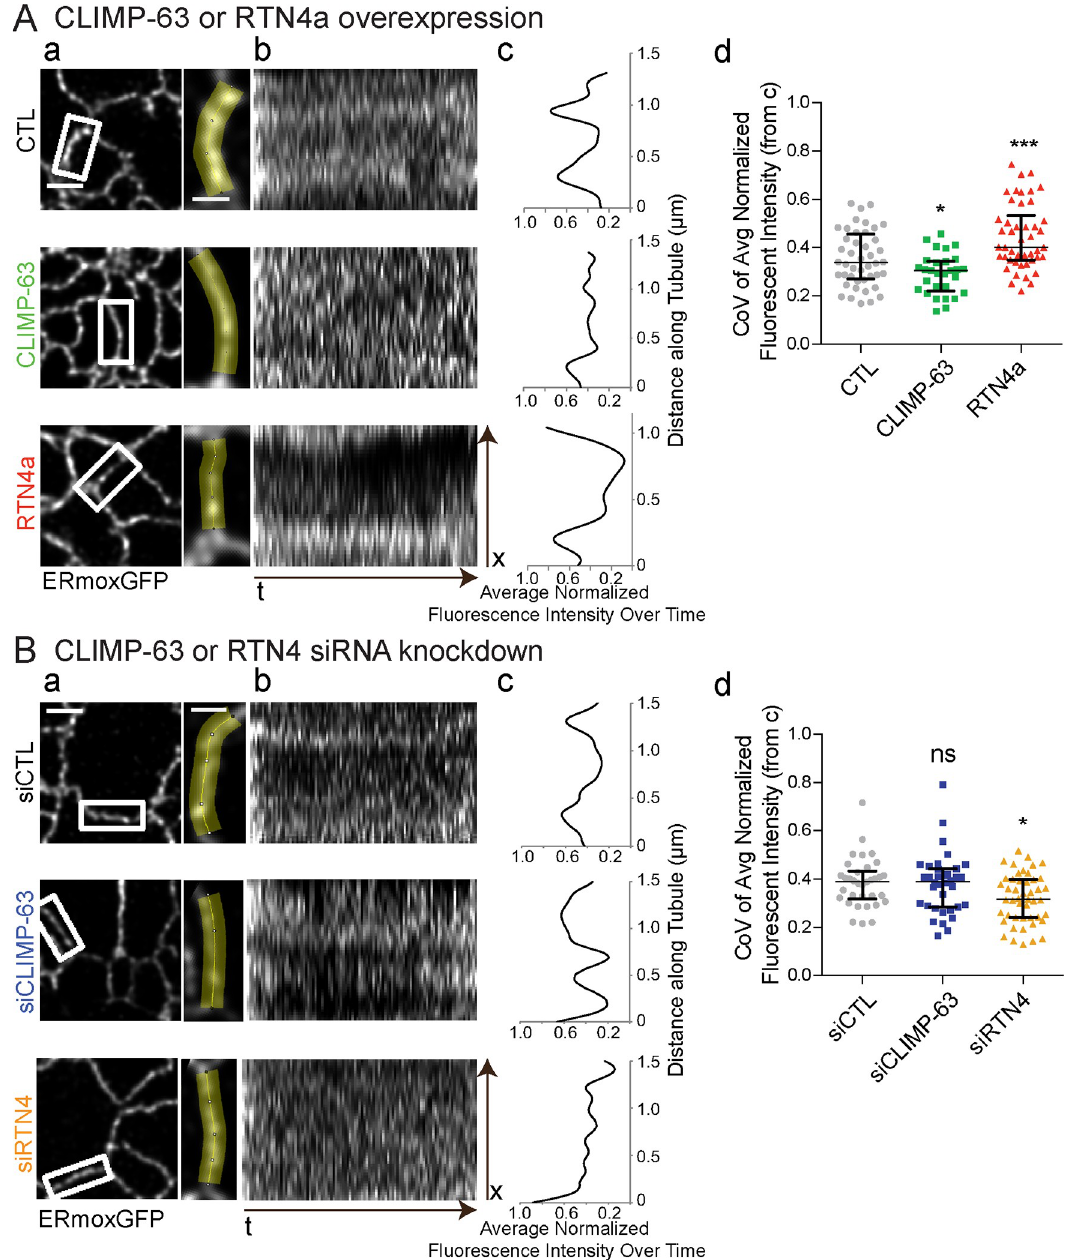
Fig 6. RTN4a and CLIMP-63 regulate dynamics of lumenal nanodomain compartmentalization along peripheral ER tubules. STED live cell imaging (40 ms/frame over 4 seconds) of isolated ROIs of peripheral ERmoxGFP-labeled tubules (a) was performed for COS-7 cells cotransfected with mCherry-CLIMP-63 or mCherry-RTN4a (A) or transfected with siCLIMP-63, siRTN4, or siCTL (B). Kymograms show the distribution of ERmoxGFP at specific sites along ER tubules over time (b). From plots of normalized average intensity over time (c), we determined the CoV along the tubule length as a measure of localized distribution of ERmoxGFP to distinct domains along peripheral ER tubules (d). Scatter dot plots show median with interquartile range from three independent experiments (20–50 tubules per condition) with one-way ANOVA for significance. � P < 0.05; ��� P < 0.001. Numerical values that underlie the plots are shown in S1 Data. CLIMP-63, cytoskeleton-linking membrane protein 63; CoV, coefficient of variation; CTL, control; ER, endoplasmic reticulum; ERmoxGFP, ER monomeric oxidizing environment-optimized green fluorescent protein; ns, not significant; ROI, region of interest; RTN4a, reticulon4a; siCLIMP-63, siRNA to CLIMP-63; siCTL, siControl; siRNA, small interfering RNA; siRTN4, siRNA to RTN4; STED, stimulated emission depletion.